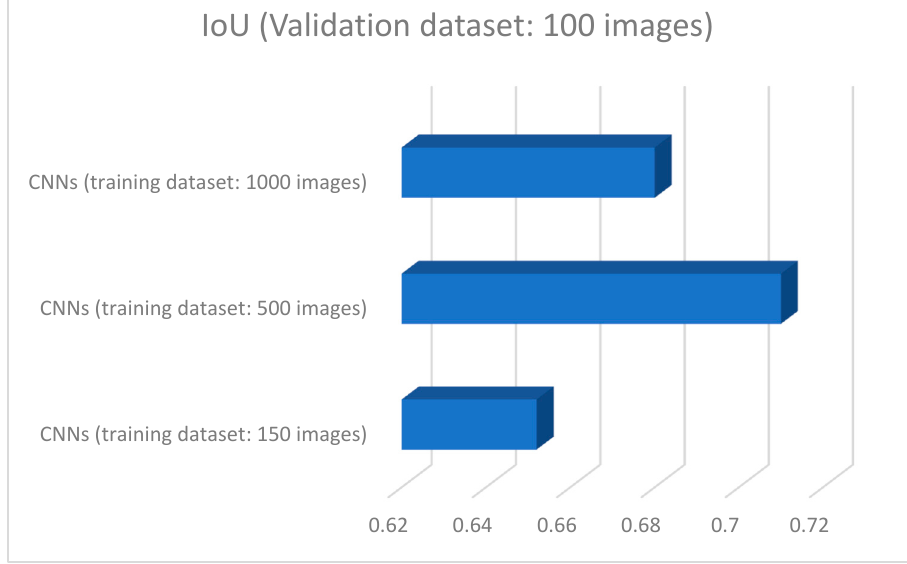
Figure 19. Intersection over union (CNNs 150, CNNs 500, and CNNs 1000).